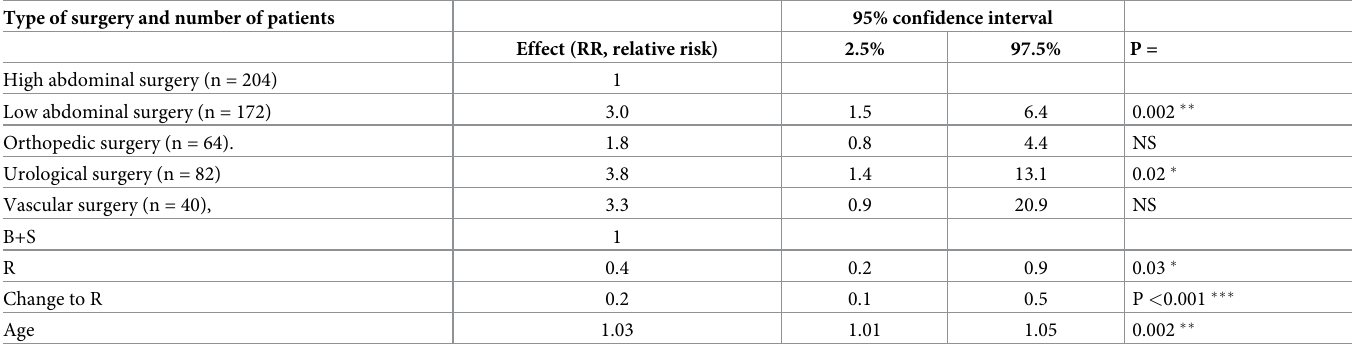
A total of 23 epidurals were discontinued prematurely after surgery. Causes for premature ter- mination of epidural analgesia are presented in Table 3. Table 2. Influence of different factors on patients´ satisfaction with epidural analgesia (logistic modelling). Type of surgery and number of patients